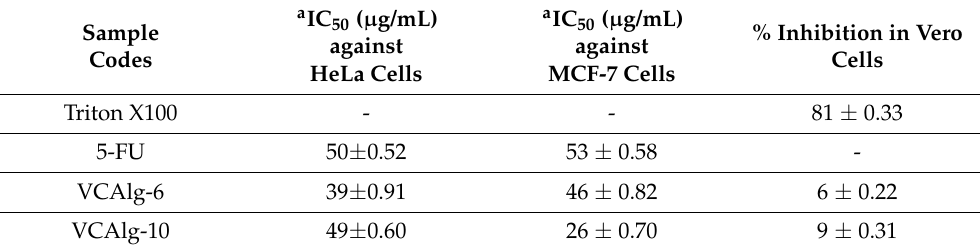
Table 5. The IC 50 values and % Inhibition of pure 5-FU solution and 5-FU loaded in thermoresponsive Poly (NVCL-g-NaAlg) in situ depot hydrogels against HeLa and Breast (MCF-7) cancer cell lines and Vero cell